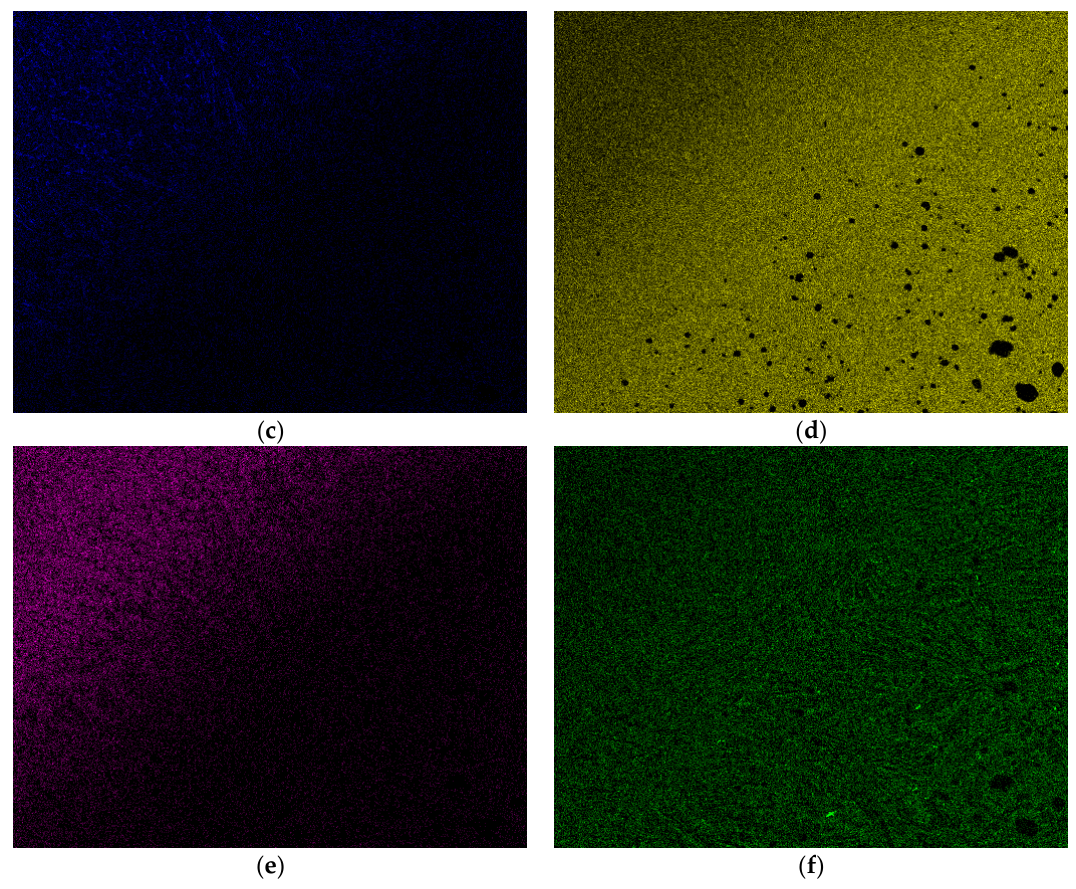
Figure 14. Surface elements mapping for sample 14_P300_N_P300_W4_P0 (UTS of 448.0 MPa): ( a ) overview of mapped area; ( b ) carbon element-mapping; ( c ) chromium element-mapping; ( d ) iron element-mapping; ( e ) nickel element-mapping; and ( f ) silicon element-mapping.